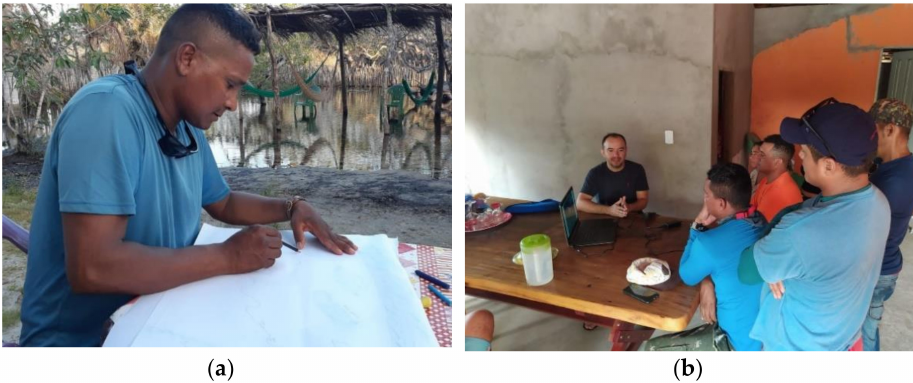
Figure 7. ( a ) Resident of the community of Bet â nia, Santo Amaro—MA drawing the mental map of the trails he uses. ( b ) Roundtable with community members and guides to introduce the ASALM